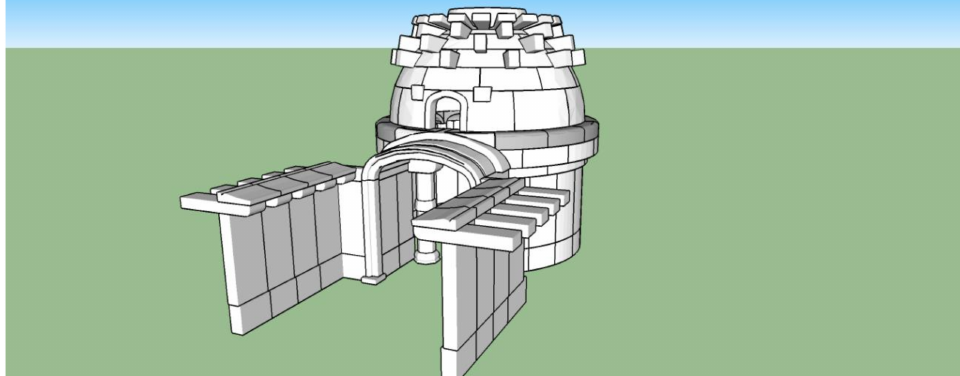
Figure 28. The model with a supposed opening in the front side to induce light effects.